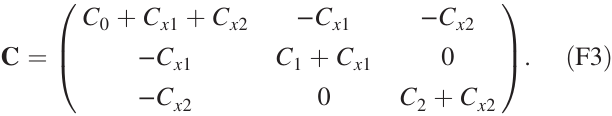
FIG. 9. Effects of nondegenerate channels (see Table II) on (a) the acquired unwanted phase and (b) population leakage from the dark state after C-NOT 2 and C 2 -NOT gate operation. The atoms assume a linear configuration with the single control or target qubit in the middle. For distances larger than 8 μ m, the phase is negligible, and the population leakage from the dark state is comparable to the nonadiabatic loss (dashed line). We assume laser coupling strengths Ω t =B 1 ¼ 0 . 1 and Ω c = 2 π ¼ 16 MHz, exciting the Rydberg states j 101 S; 109 S i